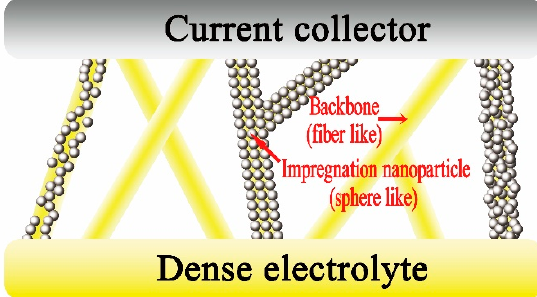
Figure 1. The schematic diagram of the theoretical model under different impregnation loadings. The shell of the impregnated particles may be smaller than one layer (left), one layer (middle), and bigger than one layer (right).